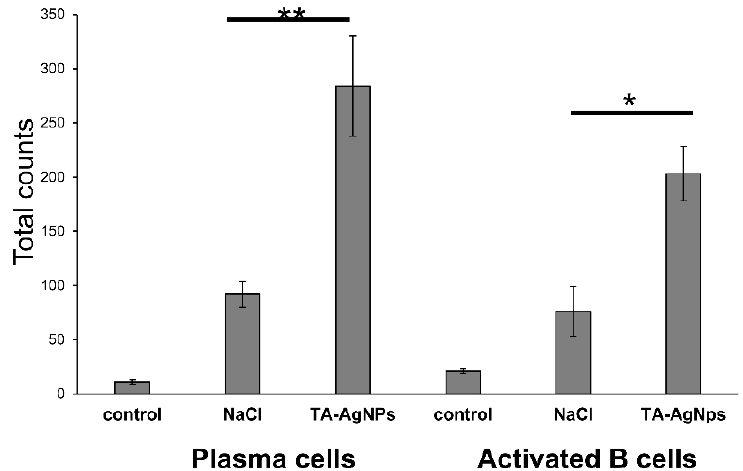
Figure 5. Treatment with TA-AgNPs helps to boost B cells ’ response after re-challenge in the vaginal tissue. C57BL6 mice were infected intravaginally with HSV-2, and treated with 5 µg/mouse of TA-AgNPs 6, 24, and 48 h after infection. Thirty days later, the mice were re-challenged with the same virus dose. The cell suspensions from the vaginal tissues prepared 10 days after re-challenge with HSV-2 were stained for plasma B cells (CD138+/B220low+/IgD − ) and activated B cells (CD27+/B220+/IgD+). The means are expressed as mean ± SEM for n = 20; * represents significant differences with p ≤ 0.05, while ** means p ≤ 0.01.